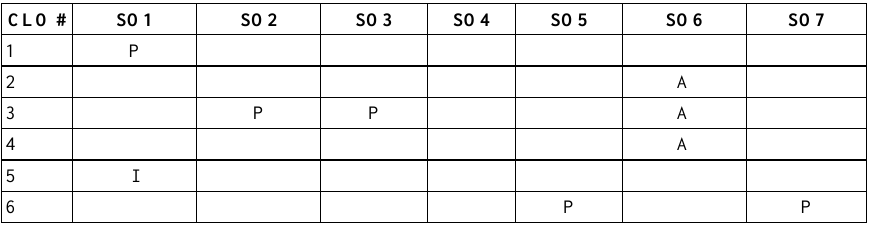
Table 3. The course learning outcomes (CLO) mapped to ABET Student Outcomes (SO) CLO #